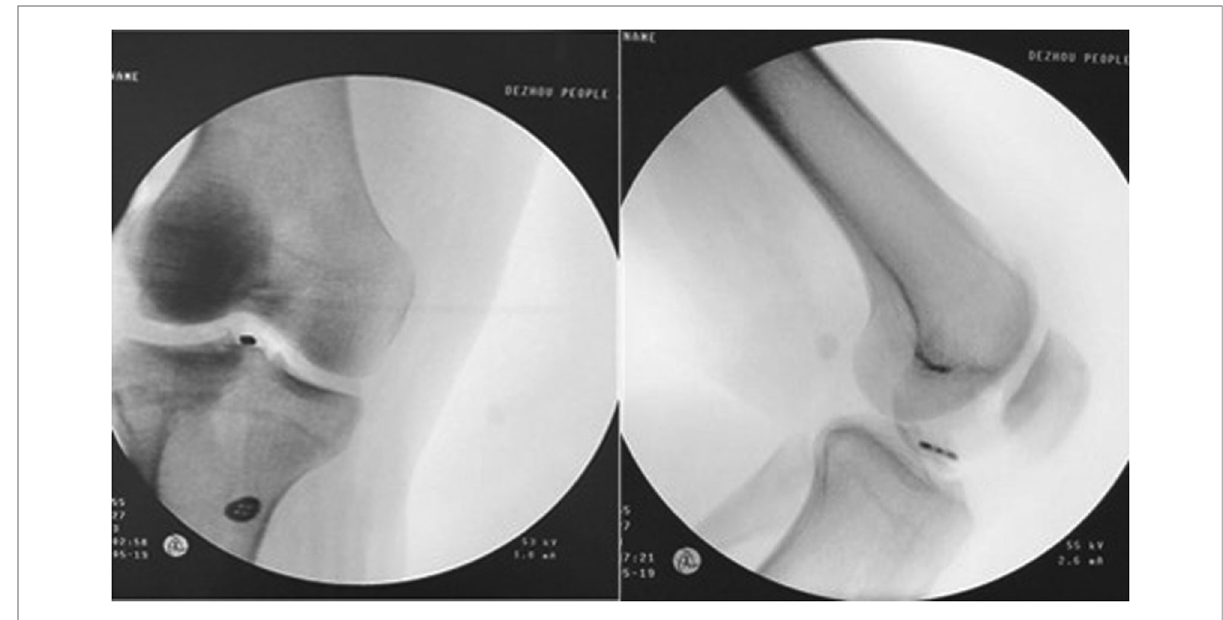
FIGURE 7 Postoperative anterior-posterior and lateral view radiographs. The ideal position ( A ).